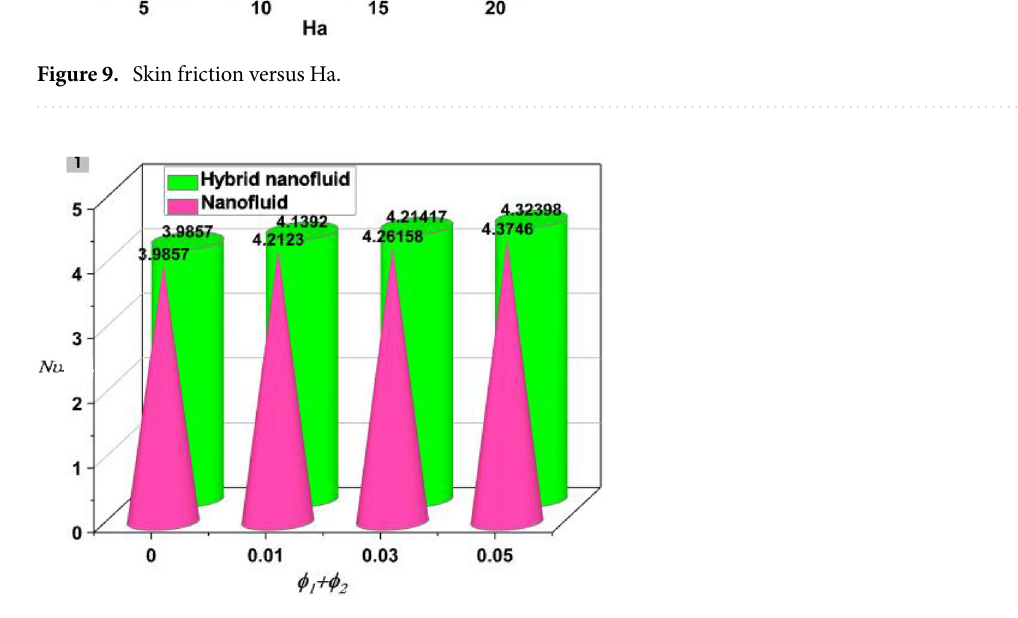
Figure 10. Nusselt number Vs volume fraction.